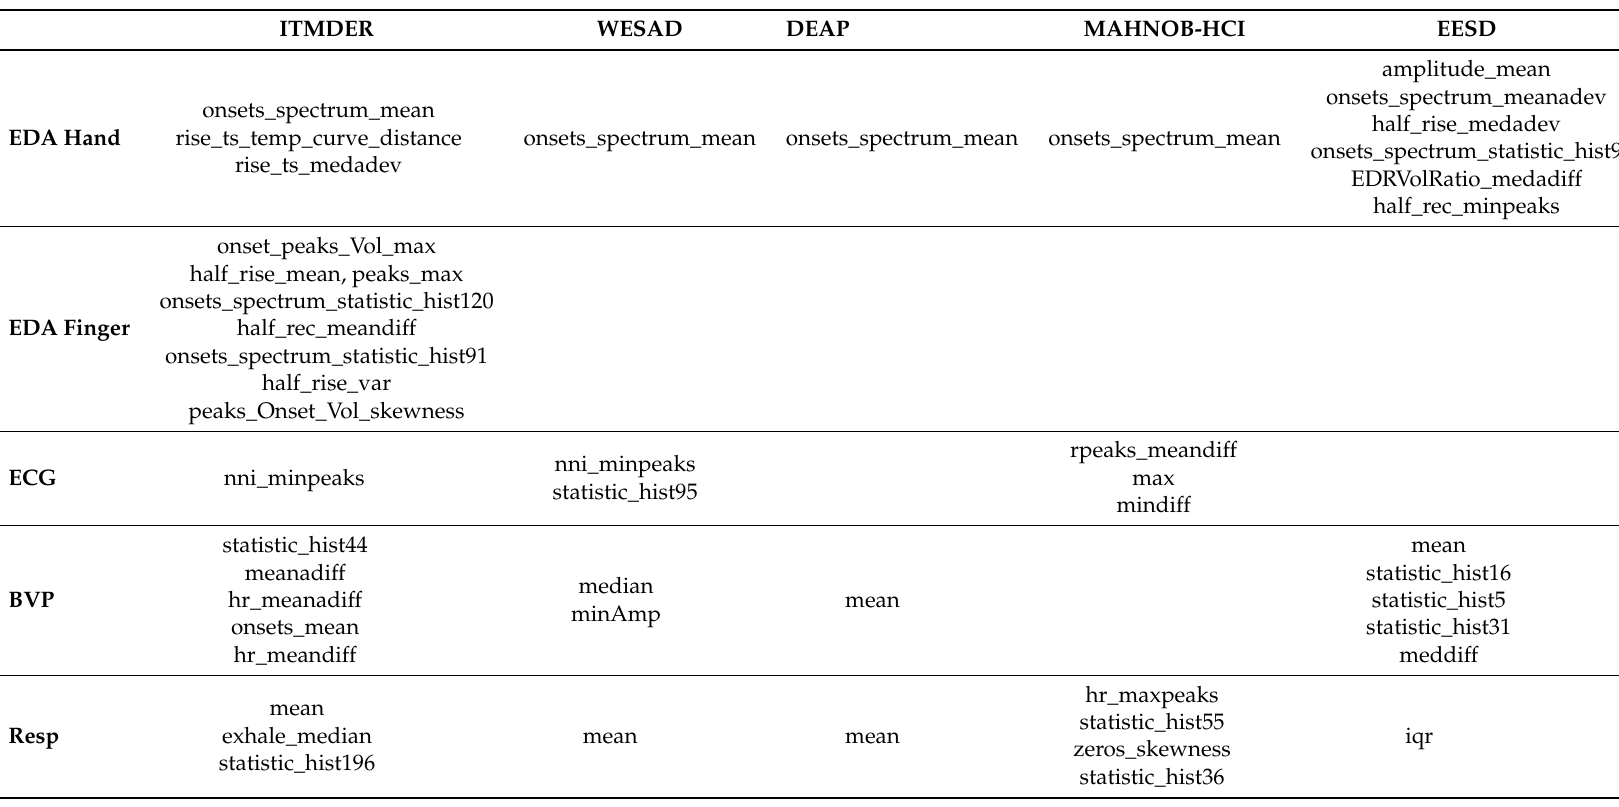
Table 5. Features used per dataset and sensor modality for the Valence dimension in the SL and DF methodology, obtained using 4-fold